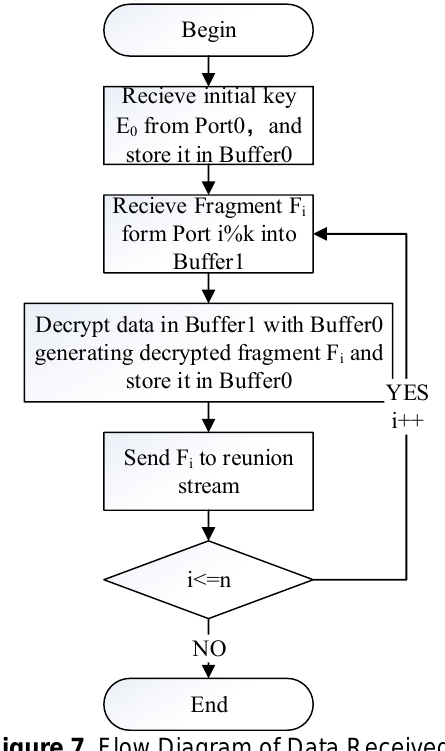
Figure 7. Flow Diagram of Data Received and Decrypted